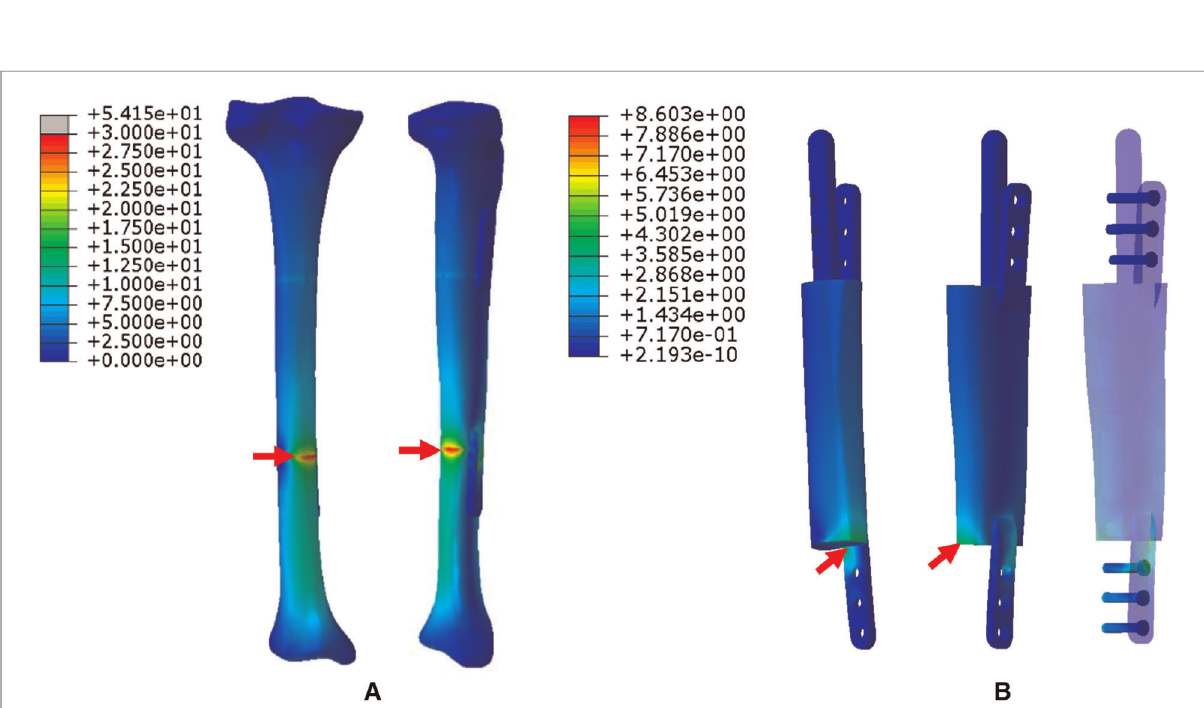
FIGURE 6 Von Mises stress distribution in Mode II, the red arrows indicate the maximum stress concentration. ( A ) Stress distribution of the integral structure. ( B ) Stress distribution of the prosthesis and internal fi